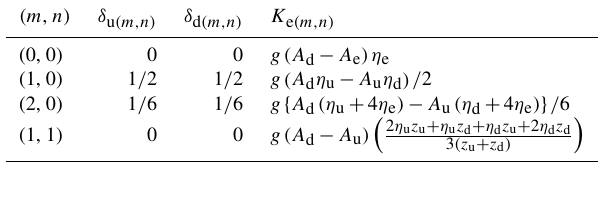
Table 2. Values for conservative Aη coefficients and K e (m,n) source terms for finite-volume schemes with ( m , n) polynomial approxi- mations of T e . Note that forms using (m , n) = (m , 1) are not recom- mended without further theoretical development and are provided only for illustrative